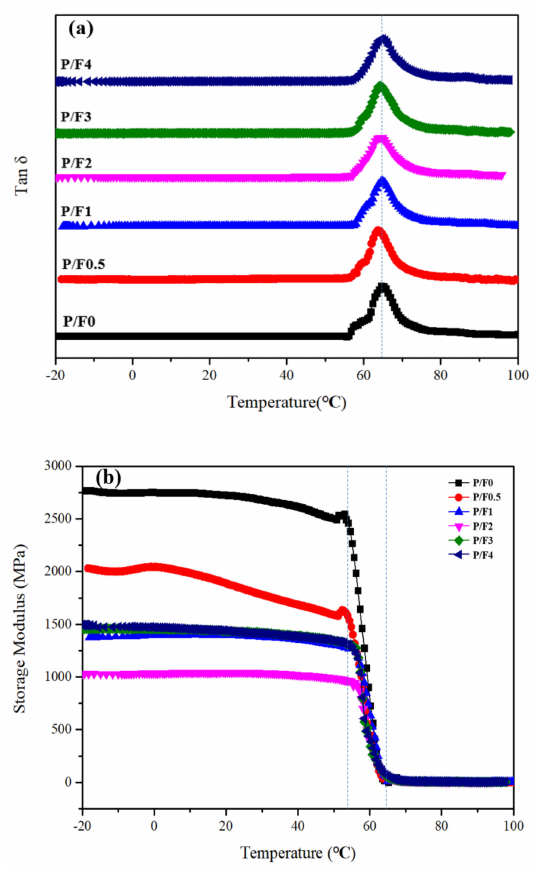
Figure 11. P/F film of ( a ) tan δ ( b ) storage modulus change